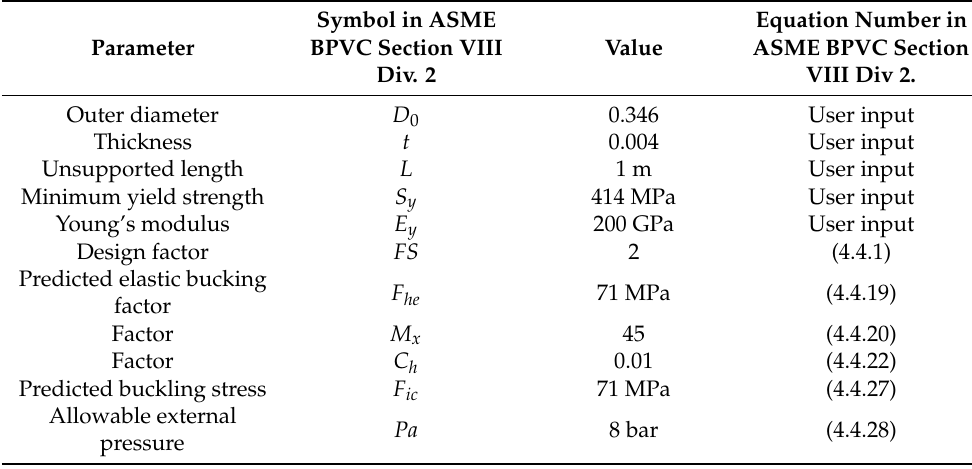
Table A7. Calculation for buoyancy tube for the SFG baseline